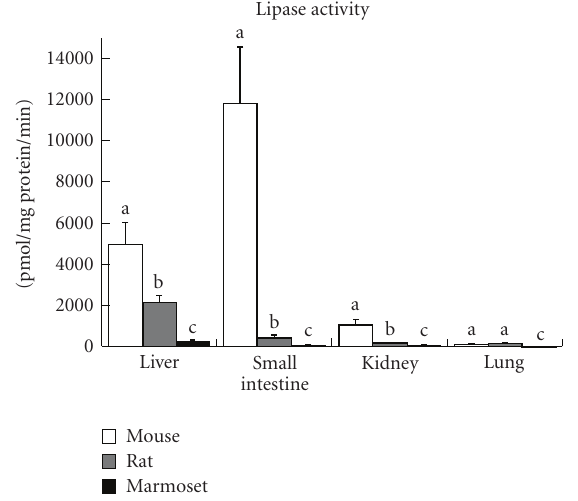
Figure 1: Species di ff erences in lipase activities (pmol/mg protein in microsomal fragment/min) using hepatic microsomes in liver, small intestine, kidney, and lung from mice, rats, and marmosets. Lipase activity was measured by GC/MS. Substrate concentration (DEHP) used was 1mM. Each white bar (6 mice), grey bar (5 rats), or black bar (5 marmosets) represents the mean ± standard deviations. Lipase activity was not detected in marmoset lung (under 1pmol/mg protein/min). Comparisons were made using analysis of variance and the Tukey-Kramer HSD post hoc test. A logarithmic transformation was applied to lipase activities in microsome samples from the small intestine and kidneys before Tukey-Kramer analysis. Di ff erent letters (a, b, c) on the top of each bar in each organ indicate that they are significantly di ff erent from each other ( P < .05).